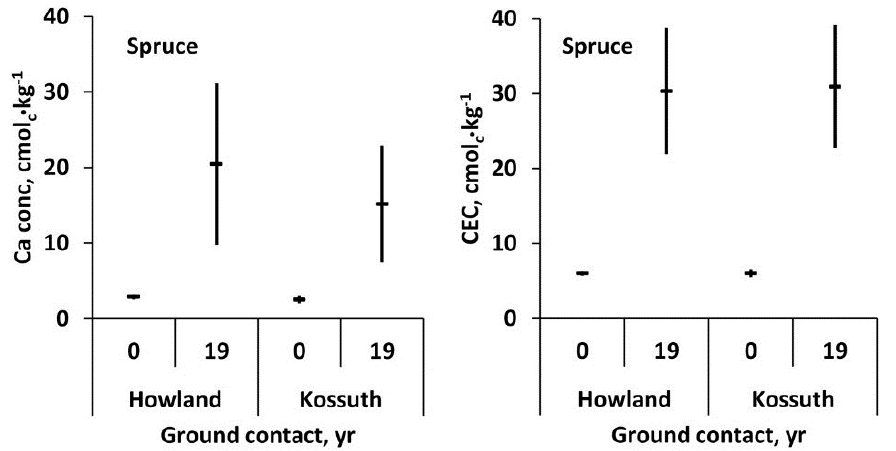
Figure 8. Mean exchangeable Ca concentration and mean cation exchange capacity (CEC) and 95% confidence interval ( n = 5) of red spruce sapwood at time of felling (0 years) and after 19 years of decay with ground contact at Howland, ME and Kossuth, ME